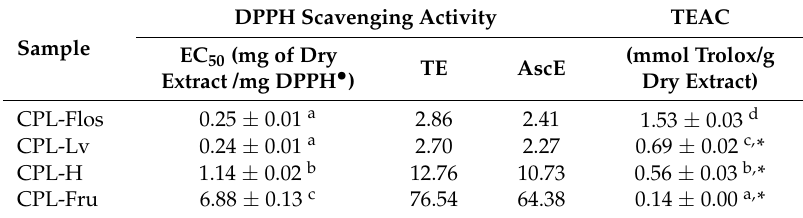
Table 5. Antiradical activity of crude polysaccharides. EC 50 expressed as mg of dry extract per mg DPPH • , TE—Trolox equivalent; AscE—ascorbic acid equivalent. Equivalents were calculated